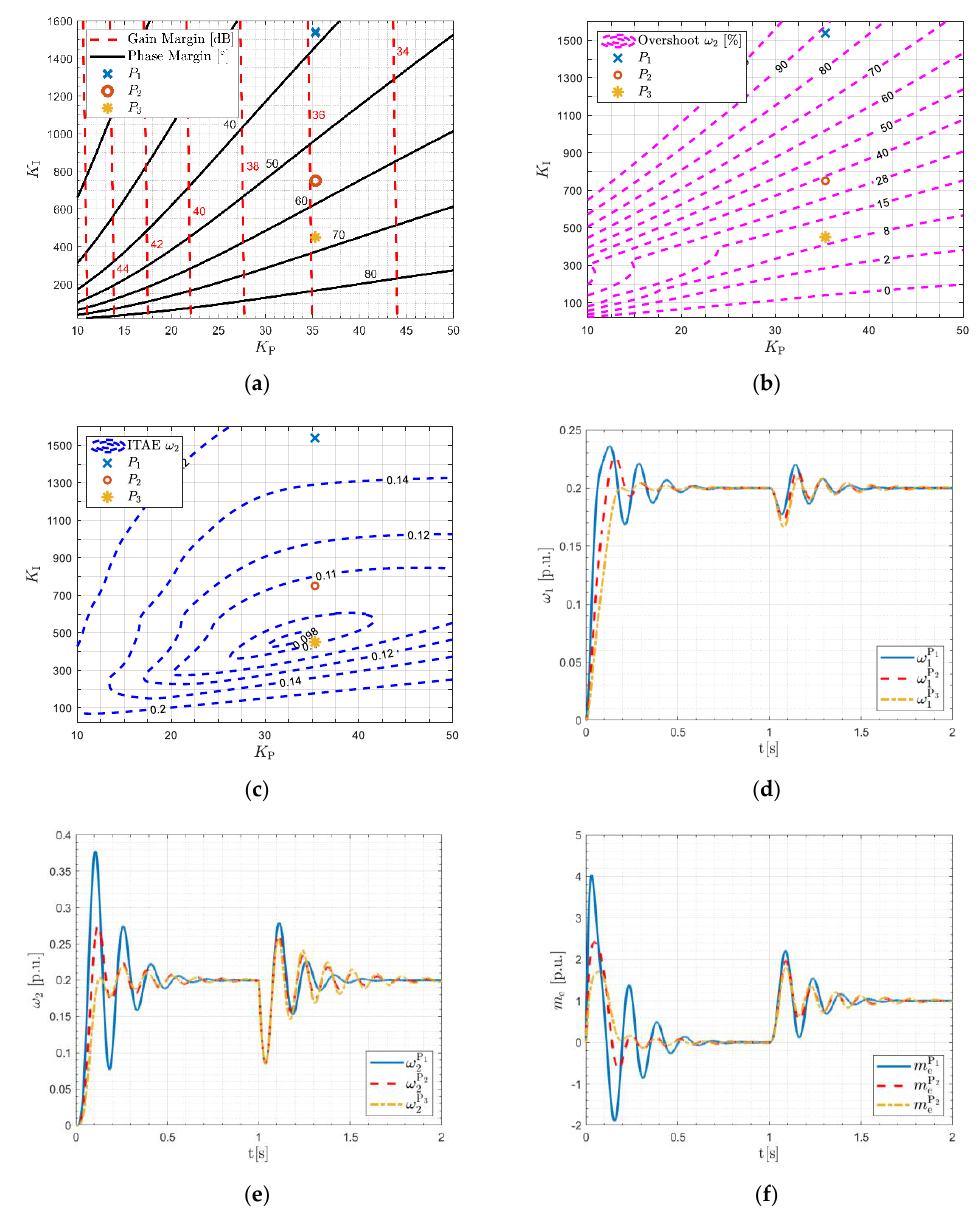
Figure 6. Characteristics of the system: stable region of work ( a ), overshoot in ω 2 ( b ), value of ITAE for ω 2 ( c ) transients of motor speed ω 1 ( d ), load speed ω 2 , ( e ) and shaft torque m s ( f ).